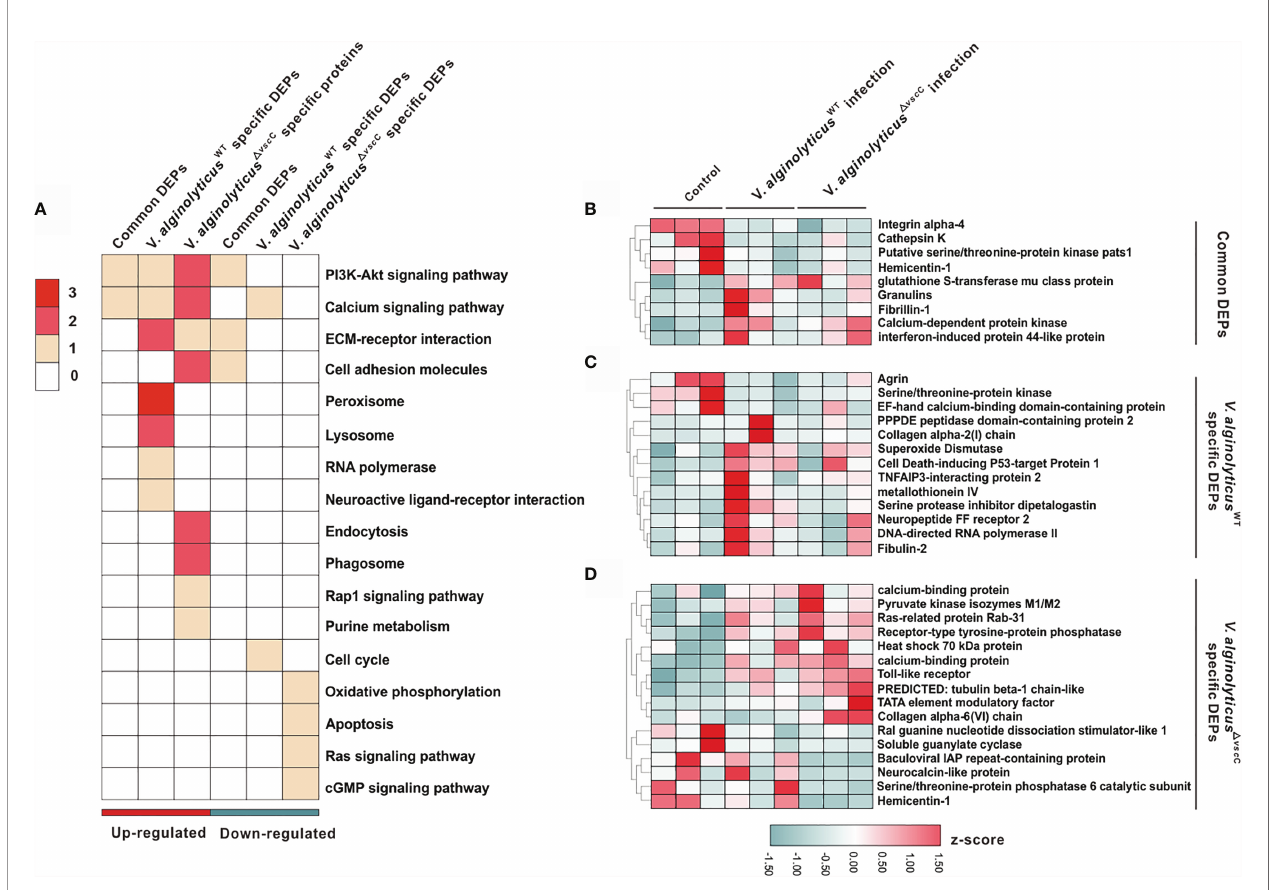
FIGURE 3 | Characterization of DEPs following V. alginolyticus WT and V. alginolyticus △ vscC challenges. (A) Distribution of enriched GO terms among three clusters (common DEPs, V. alginolyticus WT -speci fi c DEPs, and V. alginolyticus △ vscC -speci fi c DEPs). The color in each term corresponds to a given protein number. (B – D) Heatmaps of gene expression levels of DEPs were organized according to the three clusters, Common DEPs (B) , V. alginolyticus WT speci fi c DEPs (C) , and V. alginolyticus △ vscC speci fi c DEPs (D) . Protein expression levels were normalized by z -score normalization